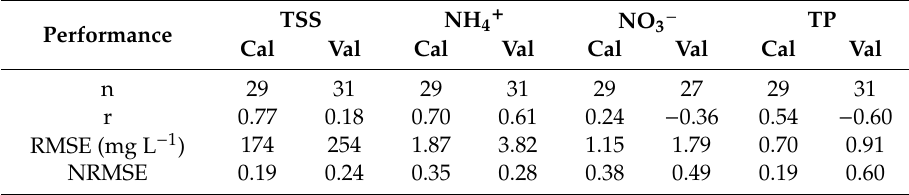
Table 5. Model performance for TSS, NH 4 + , NO 3 − and TP concentration modelling. n: number of